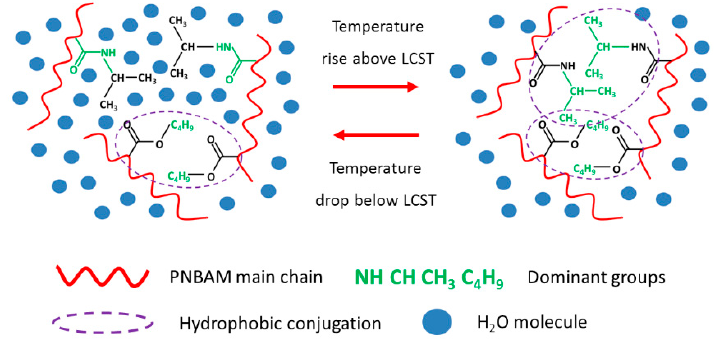
Figure 12. Rheology modulation process of PNBAM at different temperatures.